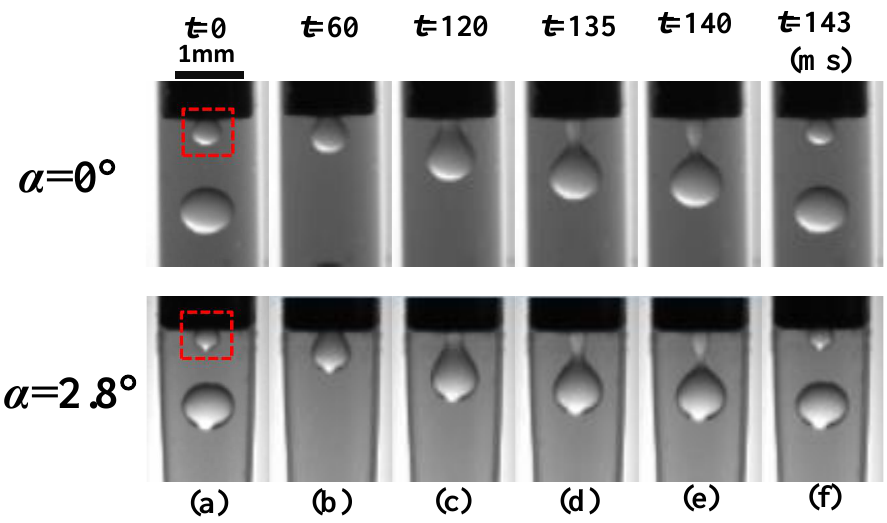
Figure 7. The formation process (one period) of a paraffin droplet under different convergence angles in the Dripping